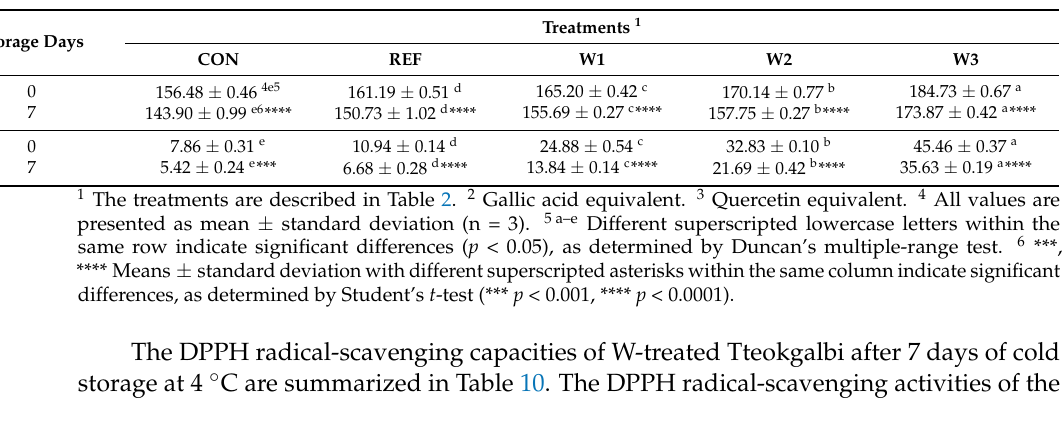
Table 9. The total polyphenol and flavonoid contents of Tteokgalbi prepared with watermelon radish powder during